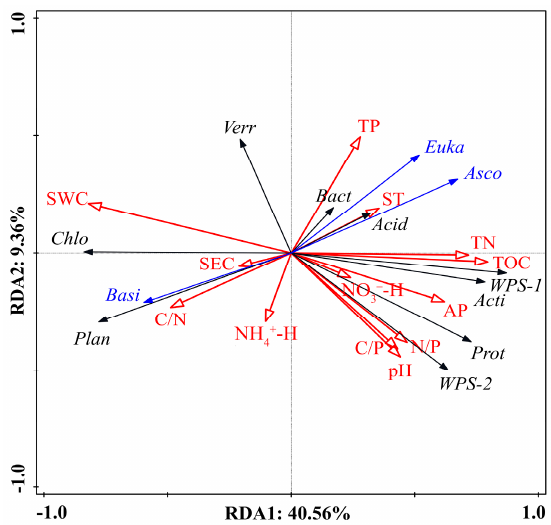
Figure 9. Ordination plots of the redundancy analysis (RDA) to determine the relationship between bacterial (black arrow) and fungal (blue arrow) phylum with relative abundance greater than 1% and soil physicochemical properties (red arrow). NH 4+ -N: ammonium nitrogen; NO 3– -N: nitrate nitrogen; AP: available phosphorus; SWC: soil water content; SEC: soil electrical conductivity; ST: soil temperature; S-ACP: soil acid phosphatase; Acidobacteria ( Acid ), Proteobacteria ( Prot ), Actinobacteria ( Acit ), Bacteria-unclassified ( Bact ), Chloroflexi ( Chlo ), Planctomycetes ( Plan ), Verrucomicrobia ( Verr ), candidate division WPS-1 ( WPS-1 ), candidate division WPS-2 ( WPS-2 ), Basidiomycota ( Basi ), Ascomycota ( Asco ), Eukaryota-unclassified ( Euka ).